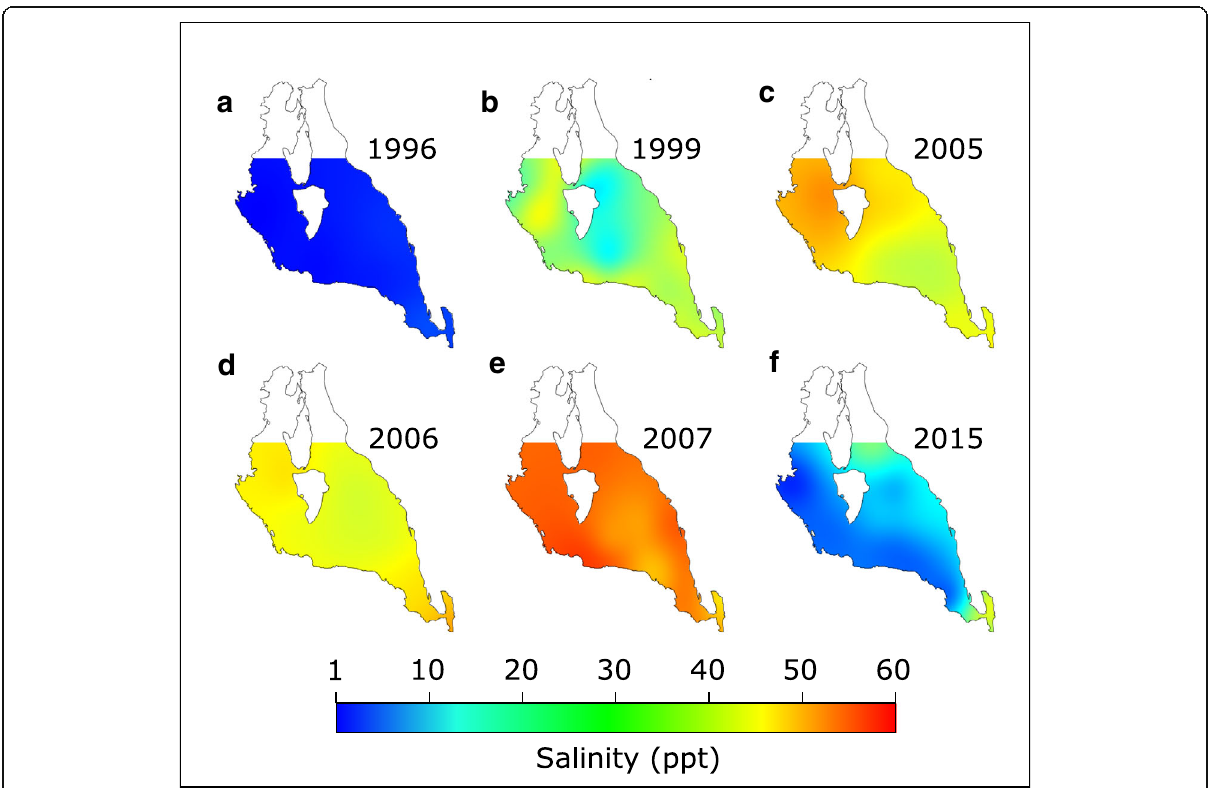
Fig. 4 Spatial models of post-monsoonal surface salinity distribution of Pulicat lagoon for multiple years obtained by interpolating the available data from different locations within the lagoon. Sources for these temporal datasets are ( a ) Padma and Periakali (1999); ( b ) IOM, No Impact Zone Studies 2003; ( c ) and ( d ) Harini Santhanam 2009; ( e ) Reddy et al. 2012 and ( f ) from the present investigation, The years 1996 ( a ) and 2015 ( f ) represent periods of highest dilution due to the northeast monsoonal rainfall, with noticeably higher persistence of the freshwater conditions in 1996 than